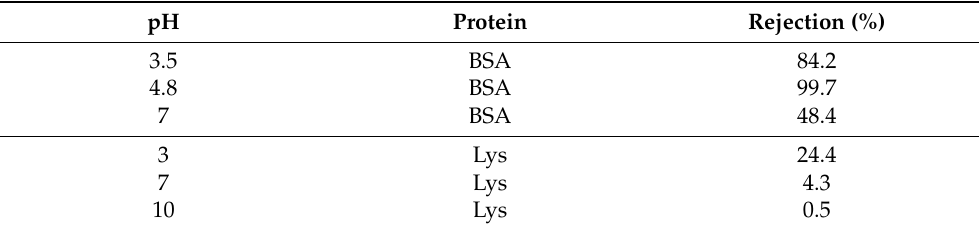
Table 3. Membrane protein rejection at the end of filtration for BSA and Lys of PVP-ZrO 2 membrane at the tested range of pH (a)